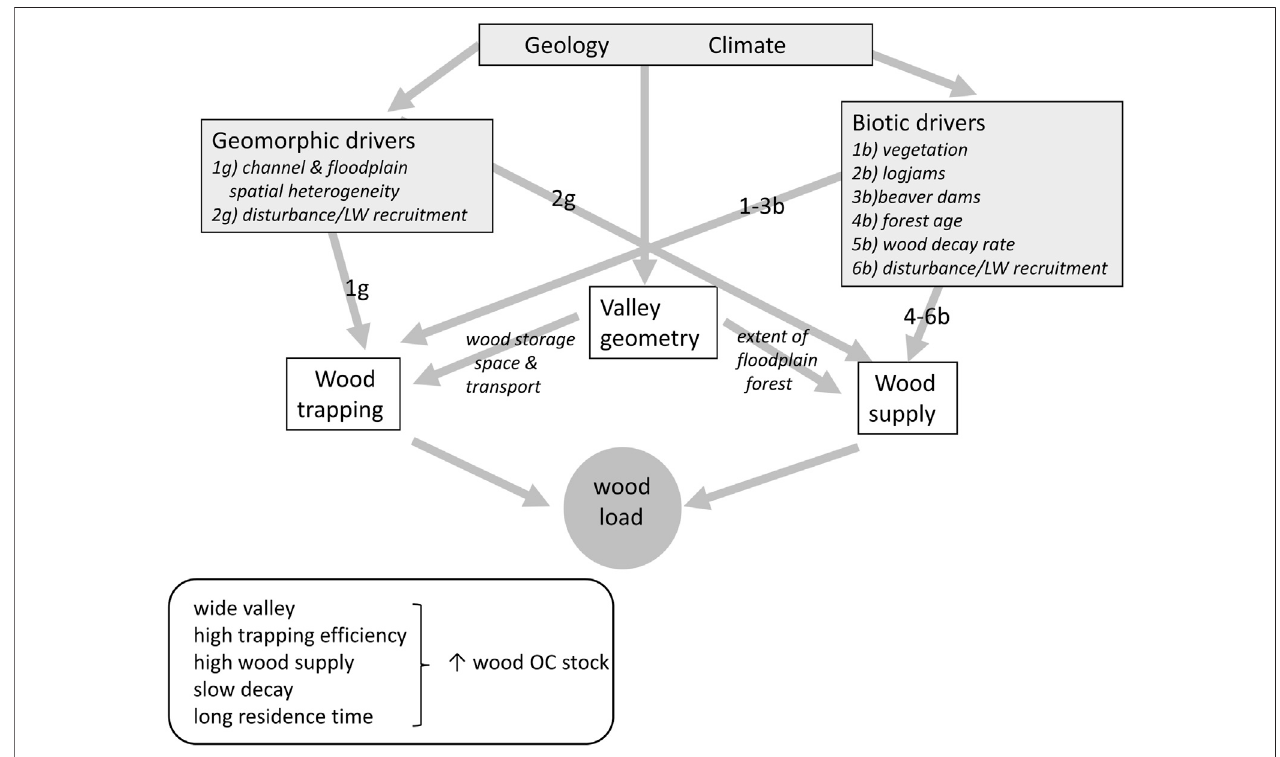
FIGURE 2 | Conceptual model for in fl uences on fl oodplain organic carbon stock in large wood. As in Figure 1 , the numbers and letters superimposed on arrows represent the speci fi c geomorphic ( “ g ” ) and biotic ( “ b ” ) drivers indicated by each arrow.